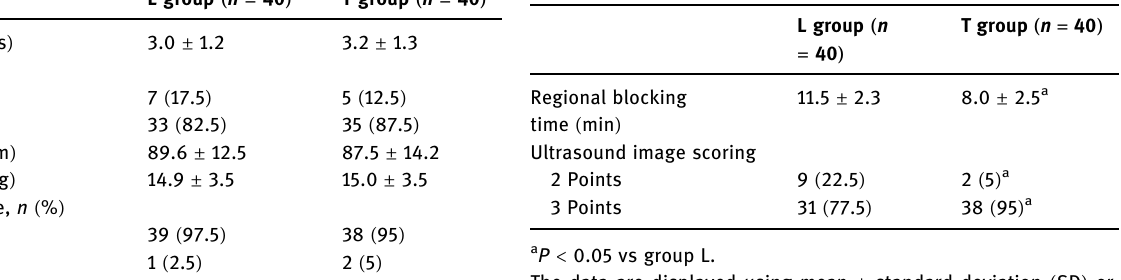
Table 1: Characteristics of the participants